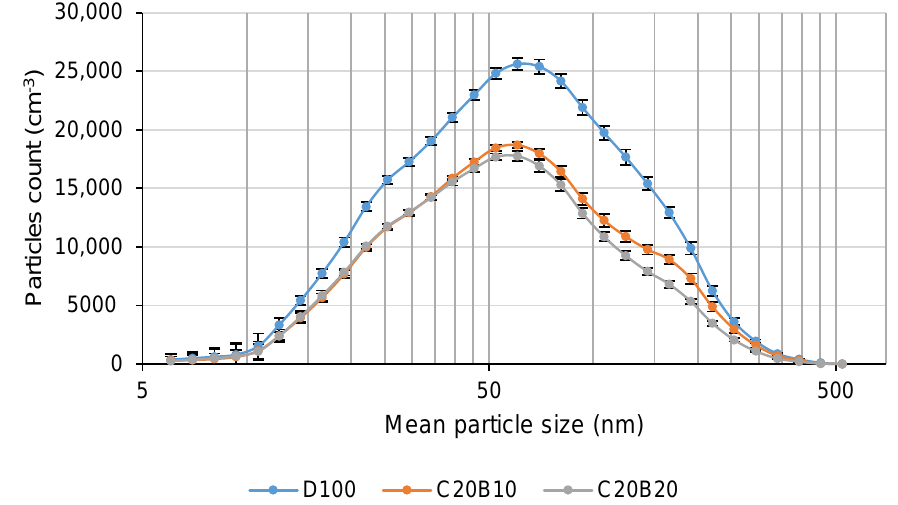
Figure 13. Size distribution of solid particles at 50% engine load (error bars represent the standard deviation).